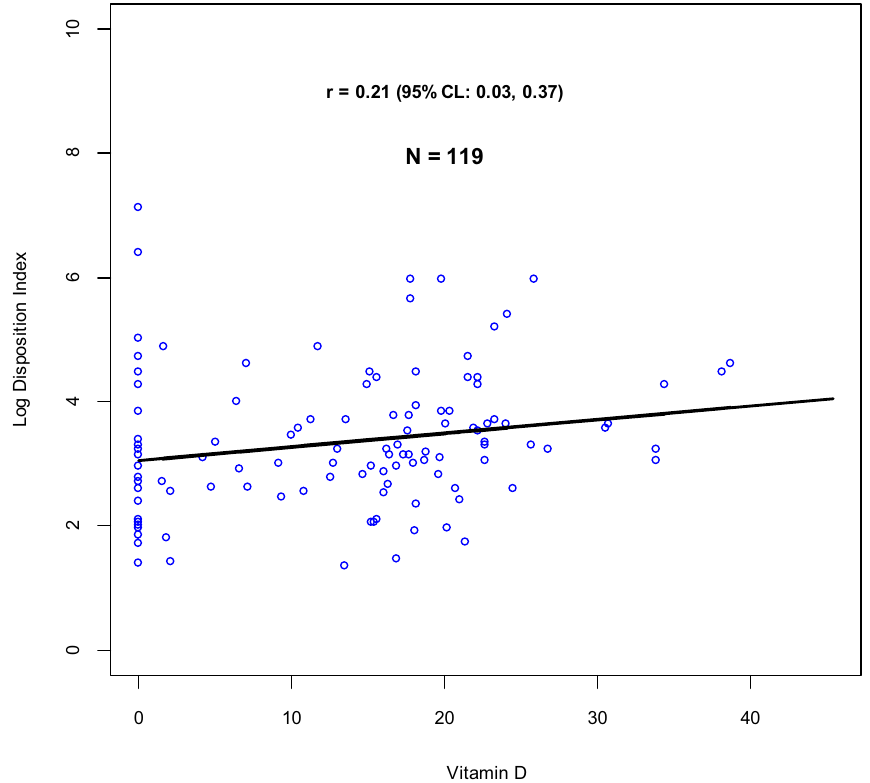
Figure 4. Relationship between vitamin D and log disposition